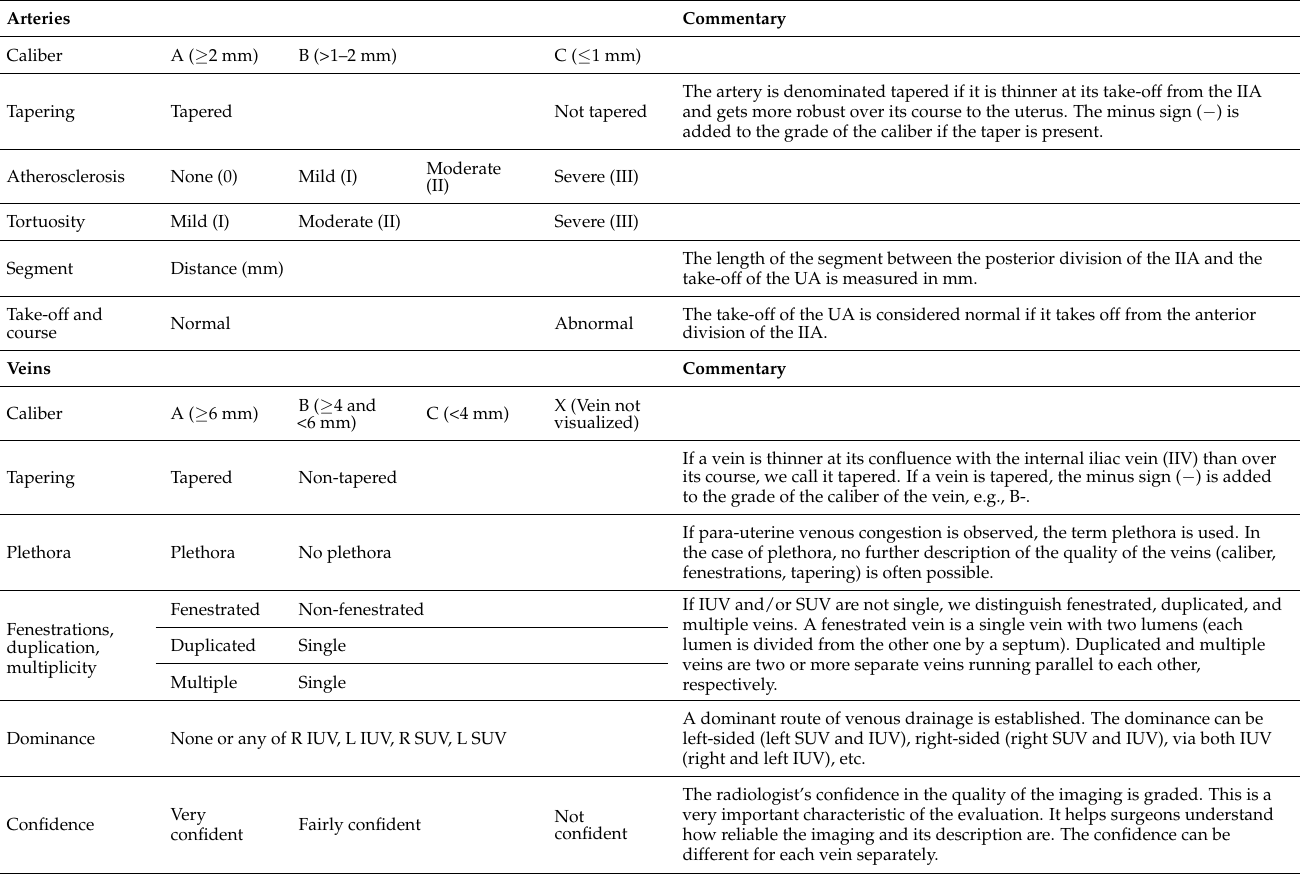
Table 1. The DUETS radiologic classification of uterine arteries, inferior and superior uterine